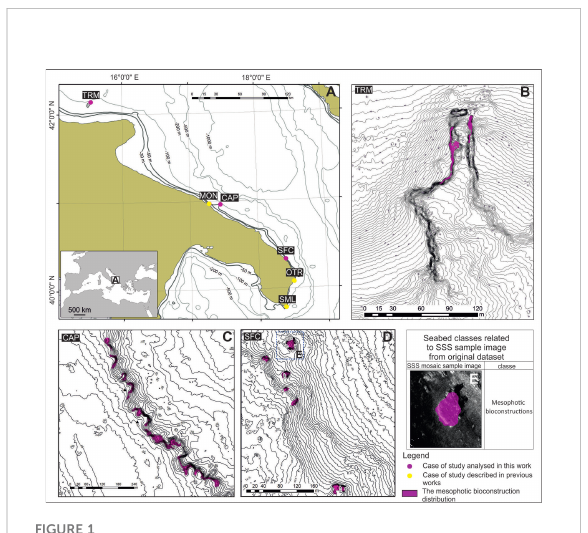
FIGURE 1 (A) Distribution of the mesophotic reefs along the Apulian coast. Yellow and purple circles show the already described reefs (MON – Corriero et al., 2019; OTR and SML – Cardone et al., 2020) and the mesophotic reefs described in the present paper (TRM, CAP, and SFC), respectively; (B-D) sea fl oor mapping (TRM, CAP and SFC shelf areas); (E) detail of the map in (D) : example of seabed classes recognized on SSS